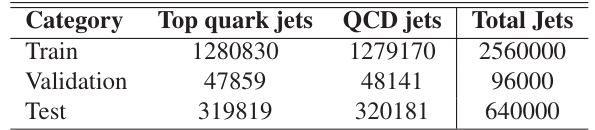
Table 1. Number of jets used for training, validation, and testing in all categories